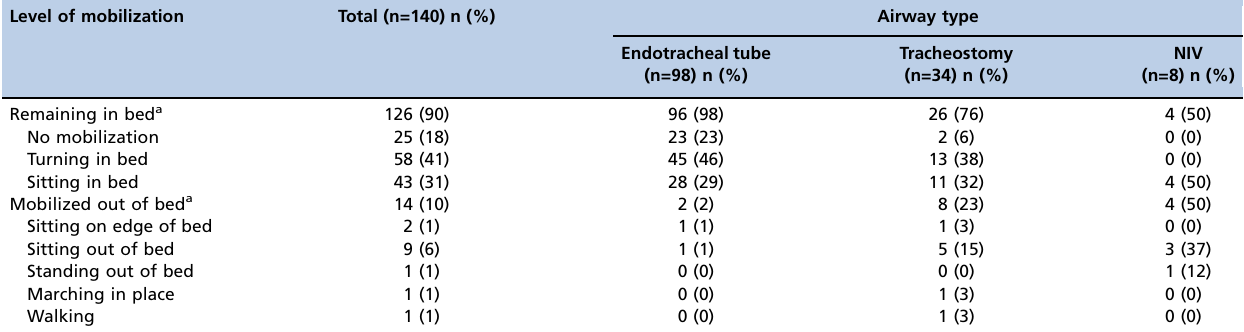
Table 3 - Highest level of mobilization achieved on the study day.